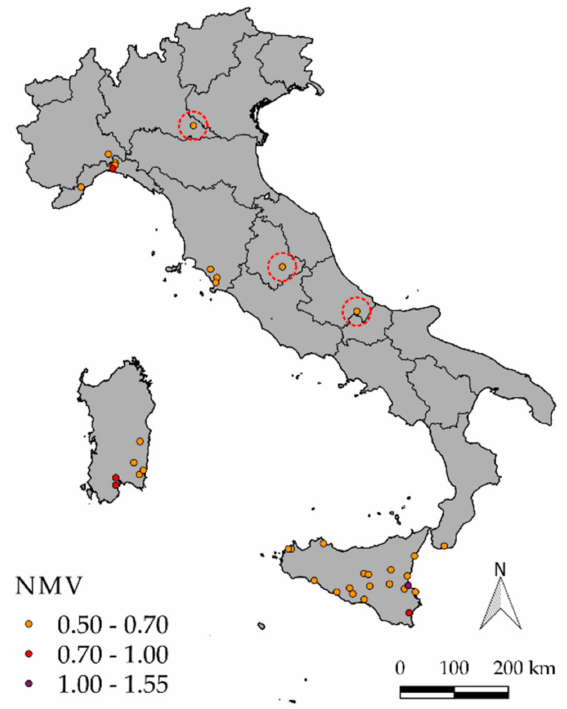
Figure 8. Rain gauges characterized by greater “Normalized” Maximum Values ( NMV ) than 0.5 for the 24-h interval. The red circles indicate anomalous values.